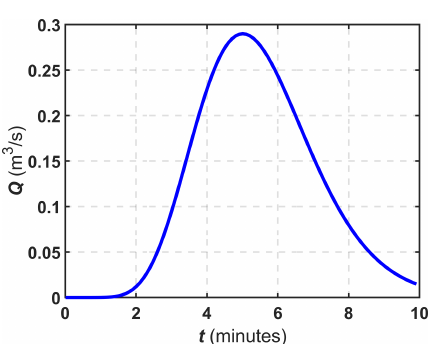
Figure 9. Inflow hydrograph produced by Eq. (4) used to generate the floodwater propagation occurring from the northeast side of the